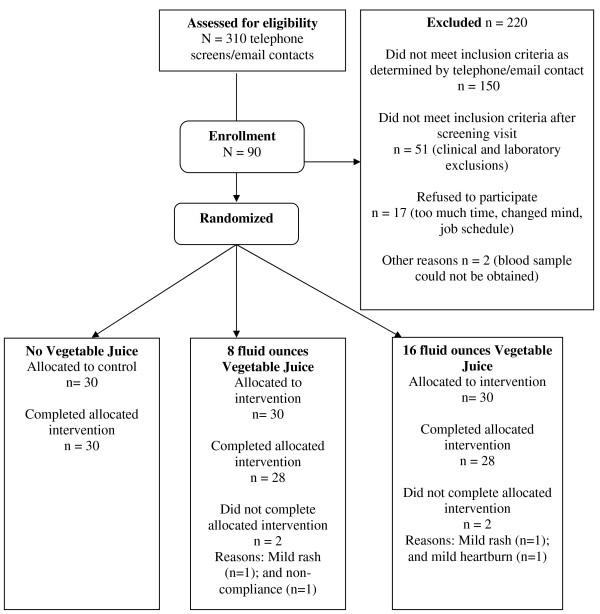
Enrollment and Randomization.